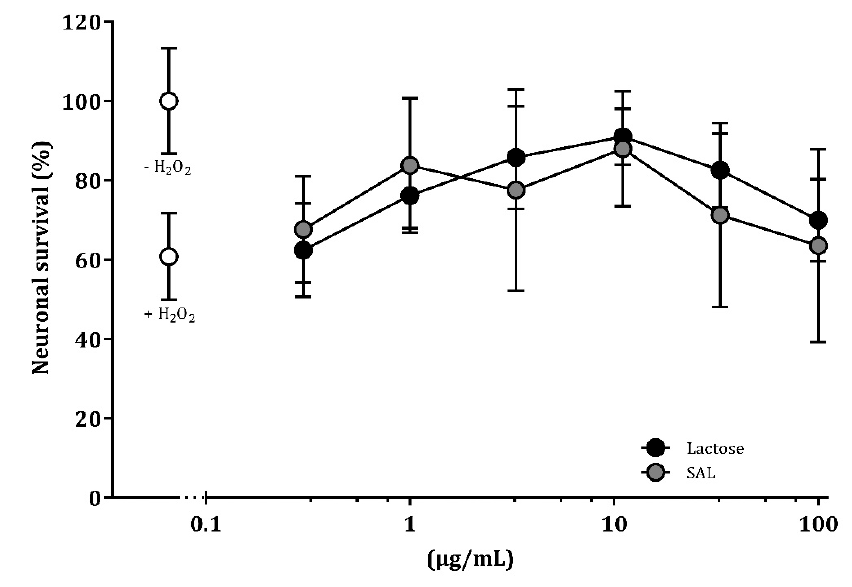
Figure 7. Dose–response effect of sialyllactose and lactose on neuronal survival. Differentiated hippocampal neurons were incubated with serially diluted oligosaccharide-enriched whey protein concentrate with sialyllactose (SAL) or lactose and treated with H 2 O 2 for 24 h. Treatment with H 2 O 2 alone resulted in 40% neuronal death compared to untreated control neurons (set to 100% survival, p < 0.001). SAL and lactose reduced cell death from H 2 O 2 treatment at concentrations of 1–11 µg/mL and 3.3–11 µg/mL, respectively ( p < 0.05). No difference was observed between SAL and lactose. Data are means ± SEM ( n = 4).